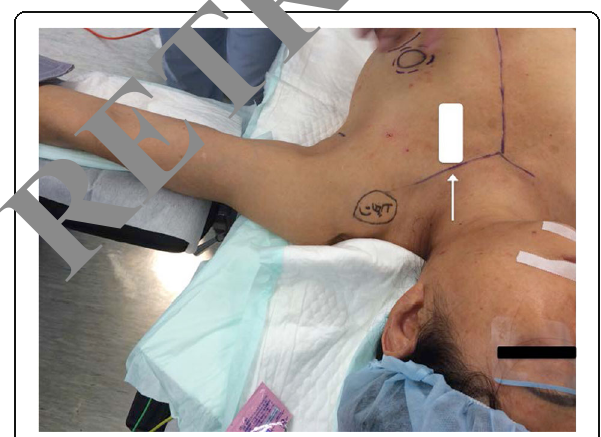
Fig. 1 Probe ’ s method. A probe is a white box , and the injection site is a white arrow